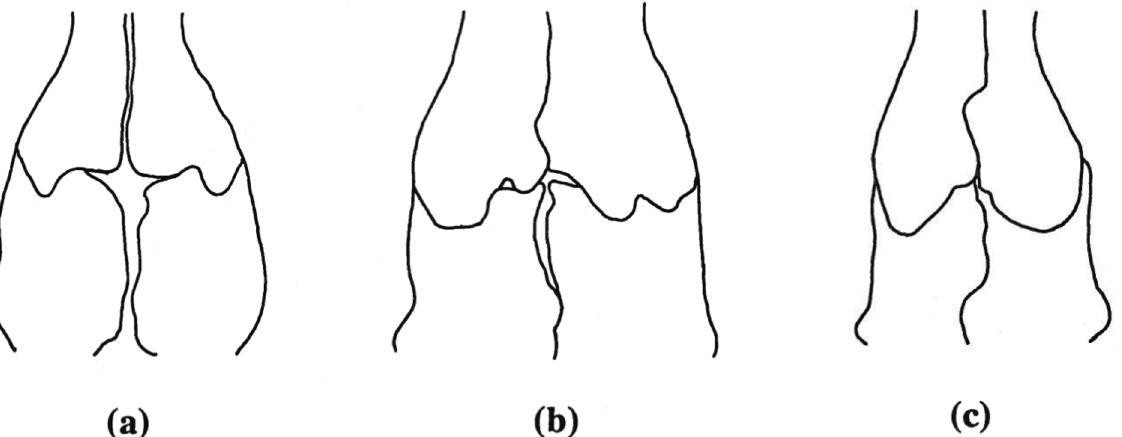
Fig 10. Frontoparietal fontanelle development. Three degrees of development of the paired frontal and parietal bones which result in the frontoparietal fontanelle being extensive (a), reduced (b), or absent (c) in Chiropterotrition . Osteological character